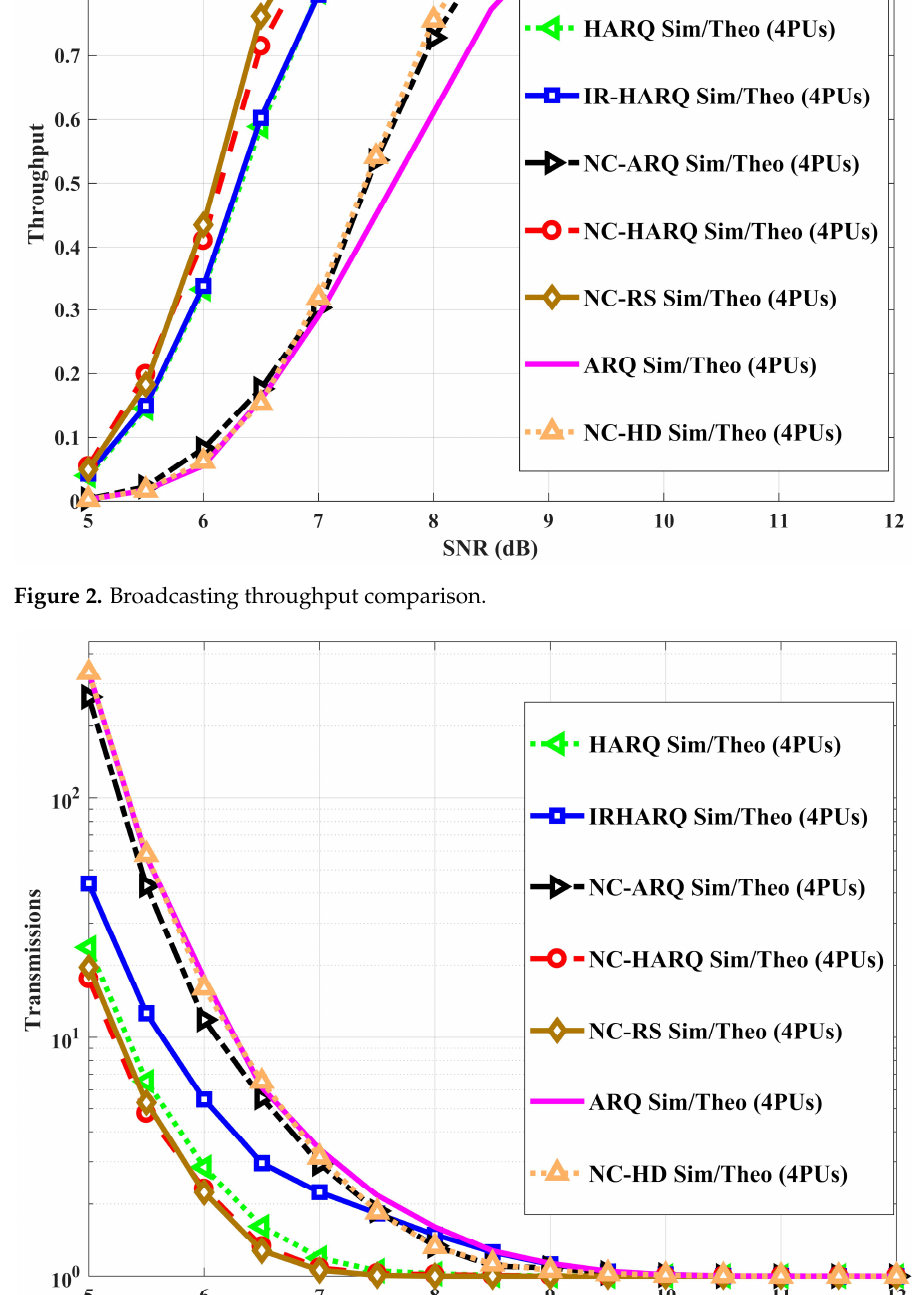
Figure 3. Broadcasting transmission times comparison.